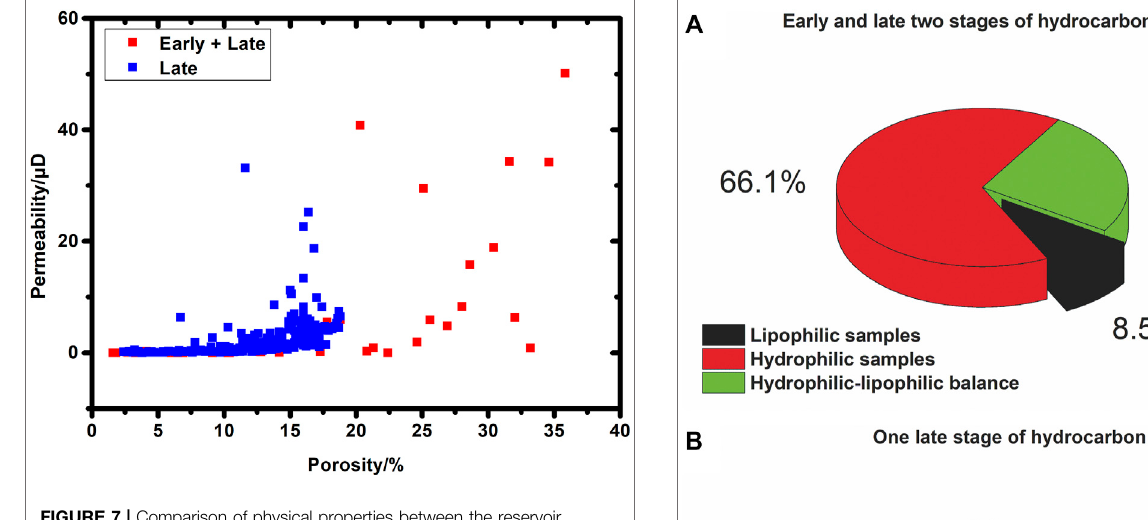
FIGURE 7 | Comparison of physical properties between the reservoir with the two hydrocarbon accumulation stages and the reservoir with the one late stage in the Dongying Dipression.